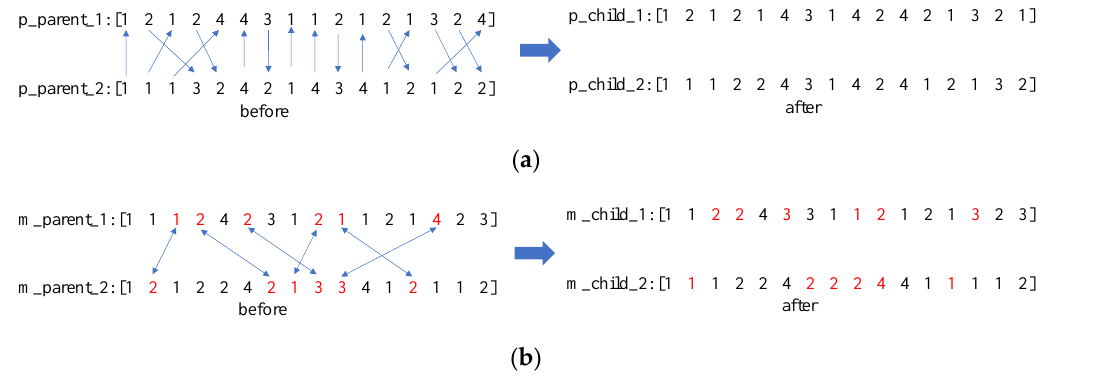
Gantt chart; ( b ) Adjusted Gantt chart.